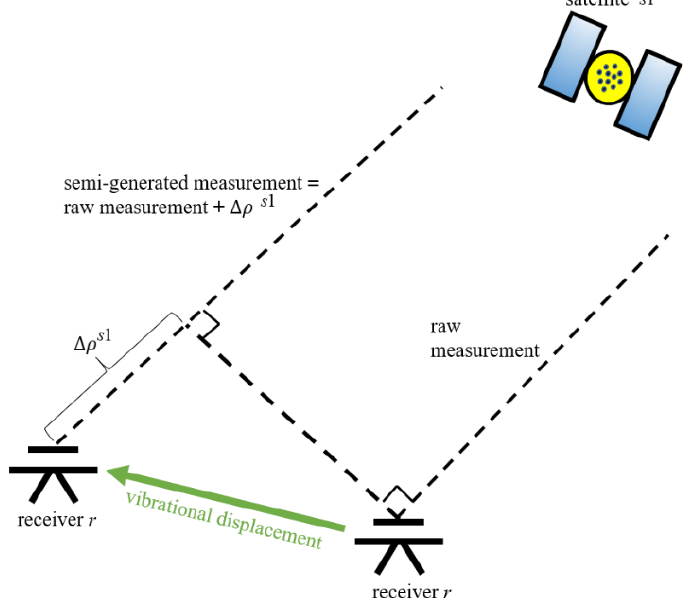
Figure 1. GNSS semi-generated measurements for satellite s 1 and receiver r.